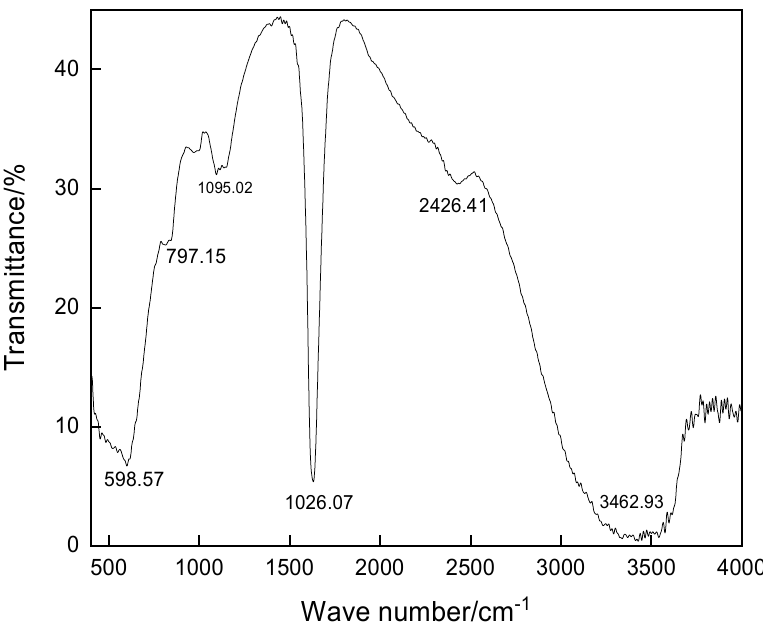
Figure 11. FT-IR spectra of the product.